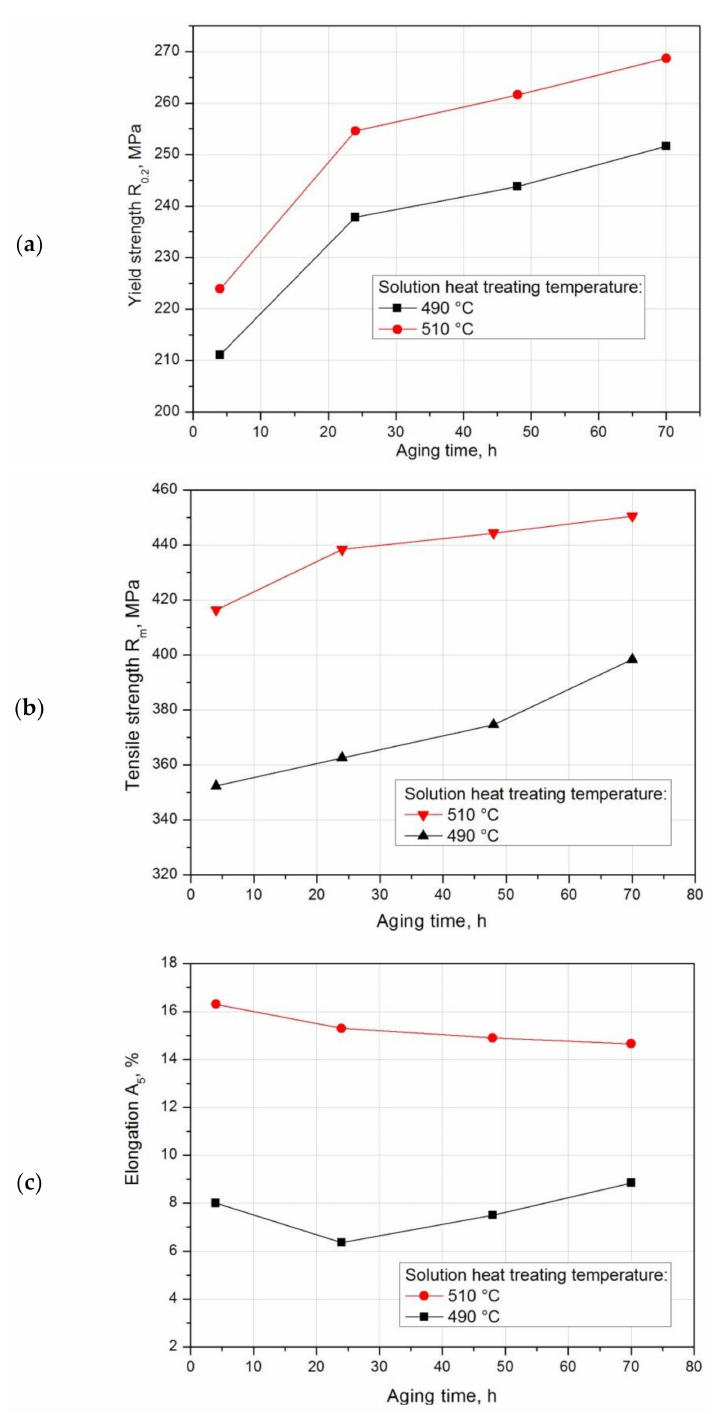
Figure 21. Influence of solution heat treatment temperature and natural aging time on ( a ) apparent yield strength R 0 . 2 , ( b ) tensile strength R m , and ( c ) relative elongation A 5 of the